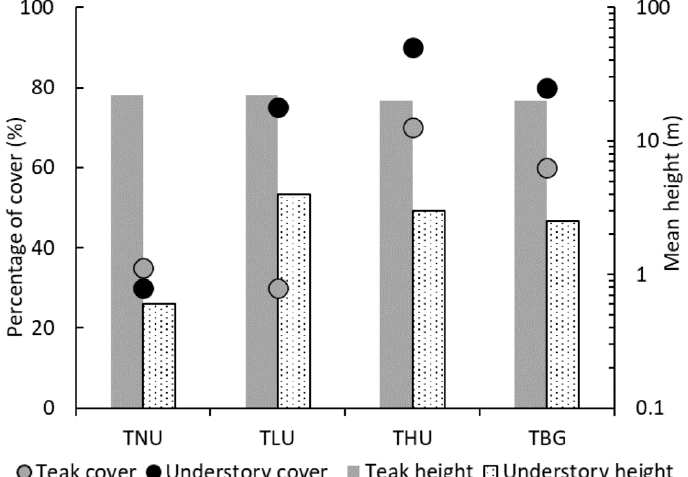
Figure 3. Percentage of cover (%) by teak trees and understory, and mean height (m) of teak trees and understory in each treatment measured on 14 December 2017, in Ban Kokngew, Luang Prabang Province, Lao People’s Democratic Republic. TNU: teak with no understory; TLU: teak with low density of understory; THU: teak with high density of understory; TBG: teak with broom grass. Water 2020 , 12 , x FOR PEER REVIEW